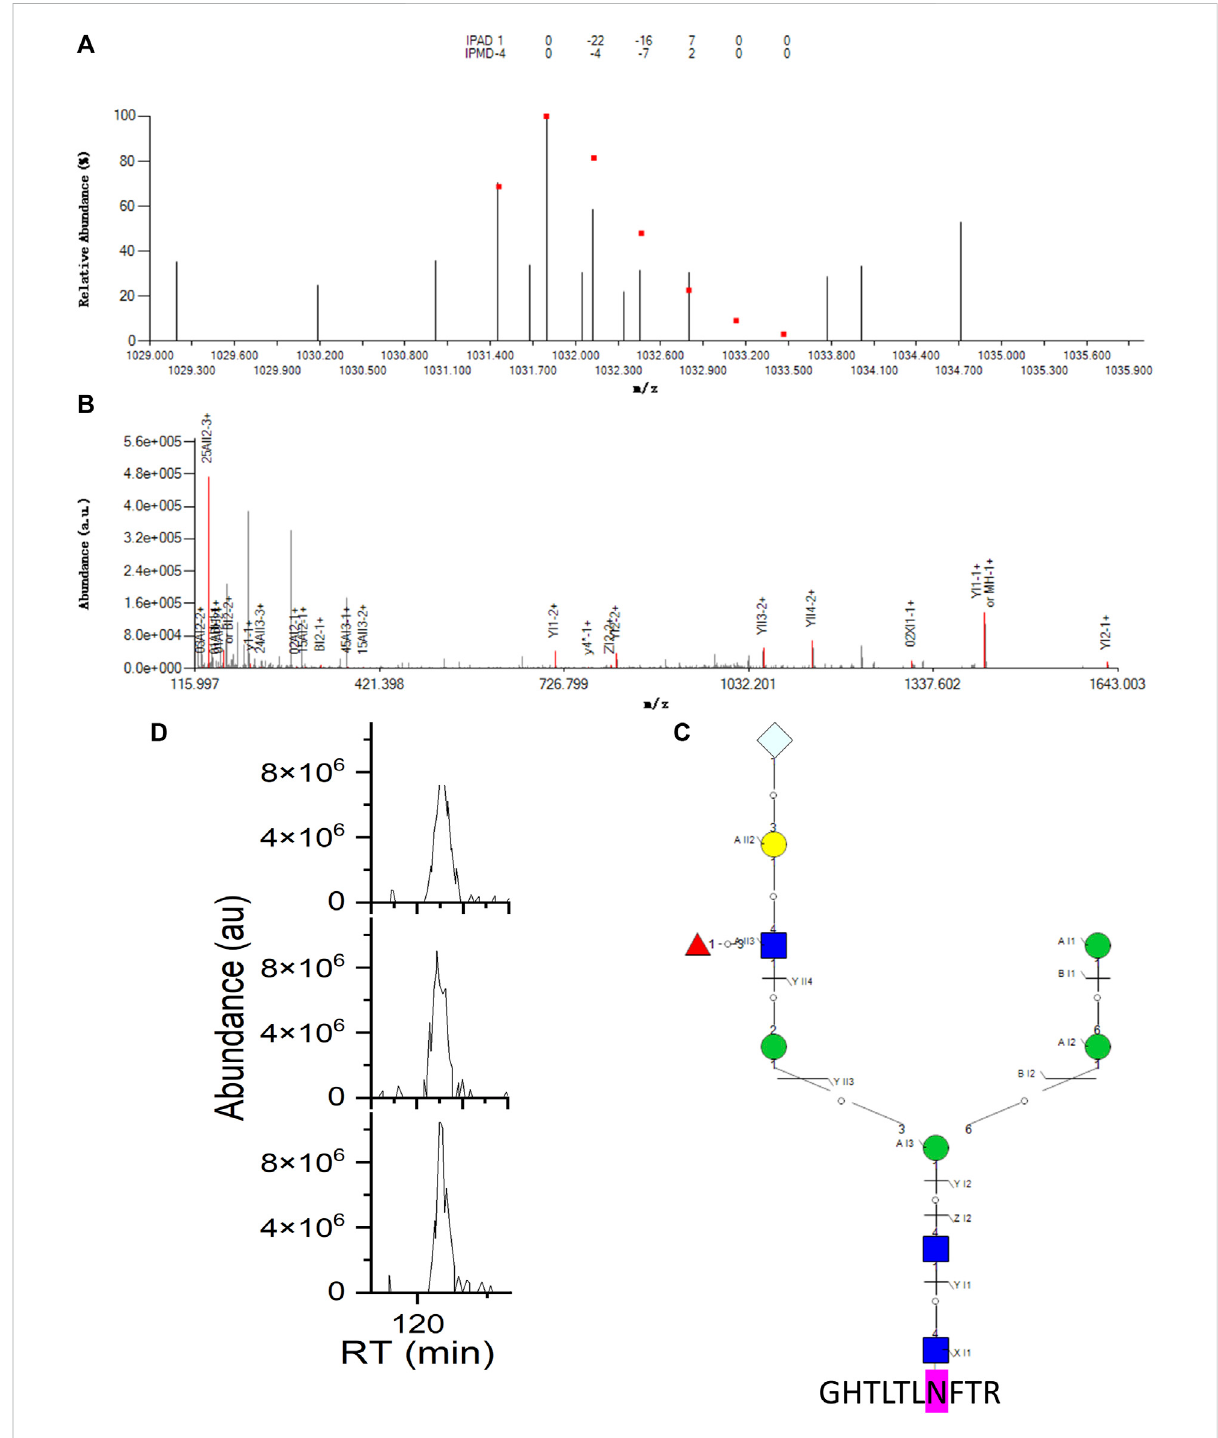
FIGURE 4 Example intact N-glycopeptide GHTLTLNFTR with a hybrid N-glycan 01Y41Y41M(31M21Y(31F)41L32T)61M-61M containing Neu5Gc identi fi ed from N-glycosite N103 of lysosome-associated membrane glycoprotein 1 (LAMP1_HUMAN, P11279). (A) Theoretical (dots) and experimental isotopic envelope fi ngerprinting map of the precursor ion. (B) Annotated MS/MS spectrum with the matched fragment ions from both the peptide backbone and N-glycan moiety. (C) Graphical fragmentation map of the N-glycan moiety. (D) Extracted ion chromatograms (EICs) of the precursor ion among three technical replicates of the RPLC-MS/MS analysis. = N-acetylglucosamine (Y), = mannose (M), = galactose (L), = fucose (F), = N-acetylneuraminic acid (S), = N-glycolylneuraminic acid (T); IPAD = isotopic peak abundance deviation, IPMD = isotopic peak M/z deviation, a.u. = arbitrary unit, RT = retention